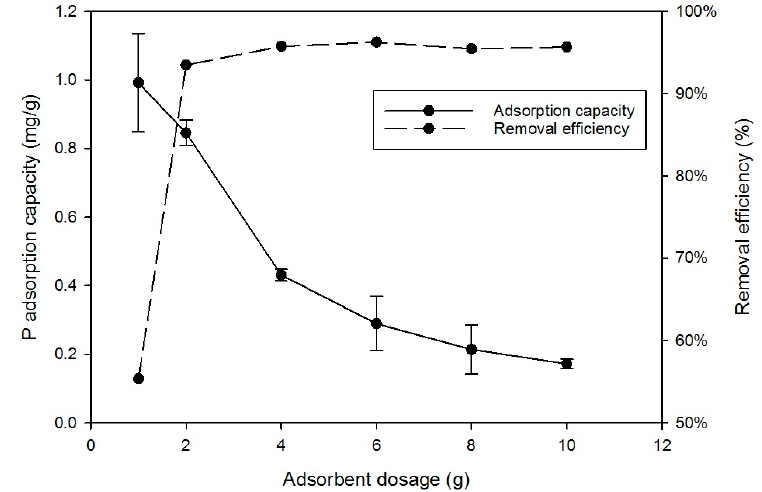
Figure 3. Effect of dose of media on sorption of P. Initial P concentration 20 mg/L; contact time 24 h; agitator 180-rpm; pH-5.